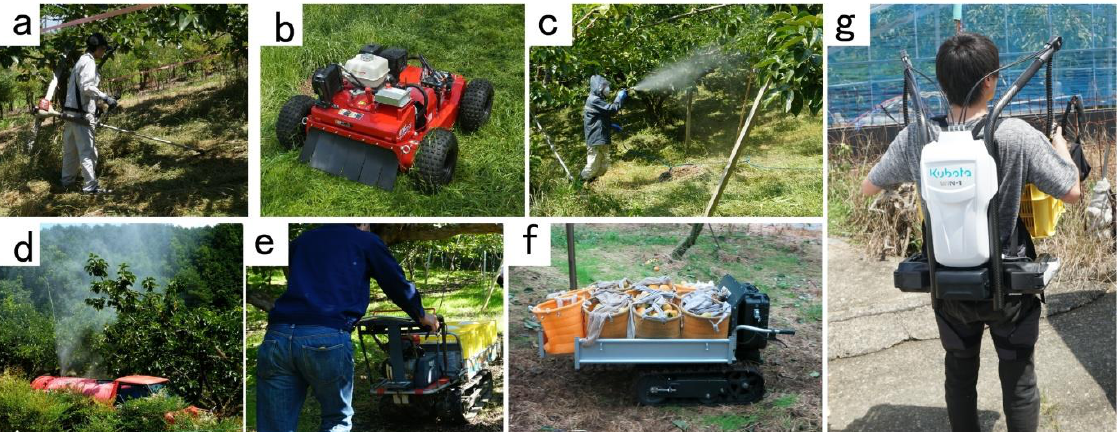
Figure 4. Farm machinery used in the experiments: ( a ) hand-held brush cutter; ( b ) remote-control weeder; ( c ) conventional engine-powered sprayer; ( d ) speed sprayer; ( e ) hand-pushed power-assisted mini crawler carrier; ( f ) remote-control mini crawler carrier; and ( g ) power assist suit.